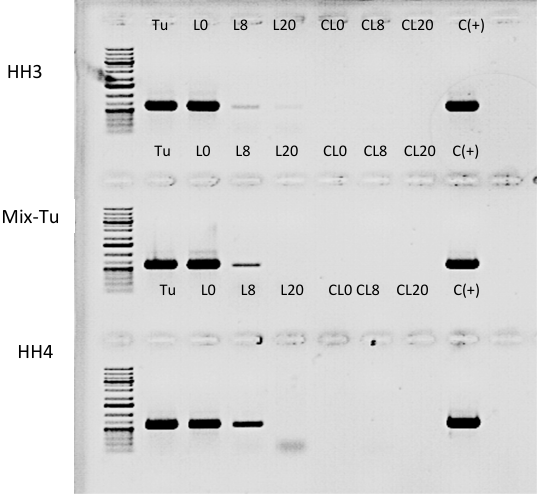
Figure 9. Transmission of TuaDV in plants. PCR from total DNA (100ng) extracted from mites, their isolated feeding leaf (L0) and two non-infested leaves at 8 and 20 cm distance (L8 and L20 respectively). Leaves from non-infested plants (CL0, CL8, and CL20) were used as negative controls, while mites were used as positive controls. Three independent F-populations were assayed (HH3, Mix-Tu, and